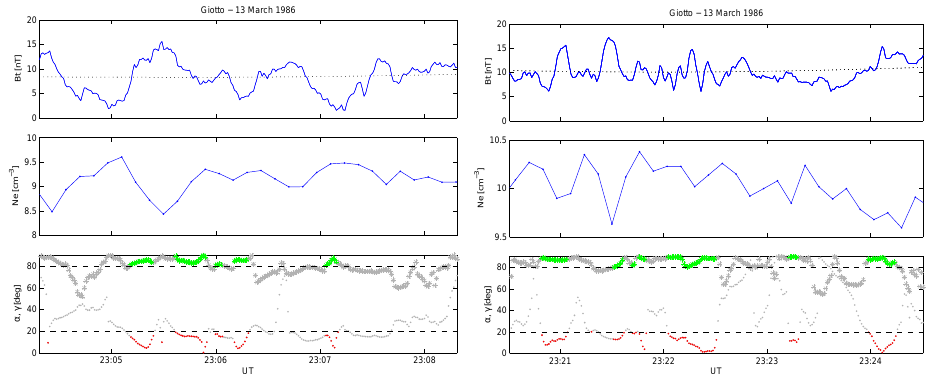
Figure 4. Examples of mirror-mode waves in the Giotto data. Top: total magnetic field with low-pass filtered (background) magnetic field as Fig. 4. Examples of mirror-mode waves in the Giotto data. Top: Total magnetic field with low-pass filtered a dashed line; middle: electron density; bottom: angles α/γ between minimum/maximum variance direction with the background magnetic field. (background) magnetic field as a dashed line; Middle: Electron density; Bottom: Angles α/γ between mini- mum/maximum variance direction with the background magnetic field.